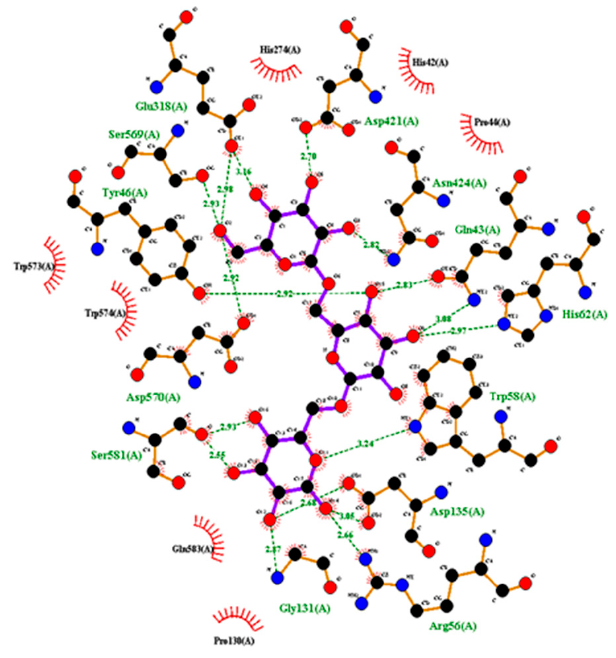
Figure 9. Force formed between ligands and receptors and amino acid sites when Pul-HJ Δ 782 uses isomaltotriose as a substrate.